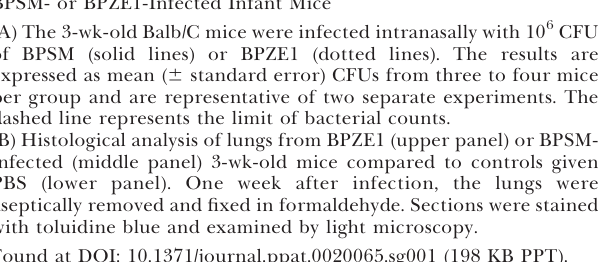
Figure S1. Lung Colonization and Histological Analysis of Lungs from BPSM- or BPZE1-Infected Infant Mice (A) The 3-wk-old Balb/C mice were infected intranasally with 10 6 CFU of BPSM (solid lines) or BPZE1 (dotted lines). The results are expressed as mean ( 6 standard error) CFUs from three to four mice per group and are representative of two separate experiments. The dashed line represents the limit of bacterial counts. (B) Histological analysis of lungs from BPZE1 (upper panel) or BPSM- infected (middle panel) 3-wk-old mice compared to controls given PBS (lower panel). One week after infection, the lungs were aseptically removed and fixed in formaldehyde. Sections were stained with toluidine blue and examined by light microscopy. Found at DOI: 10.1371/journal.ppat.0020065.sg001 (198 KB PPT). Figure S2. Immune Responses Induced in Adult Mice by BPZE1 or aPV Immunization Anti-FHA (A), anti-PTX (B), anti- B. pertussis IgG heavy and light chain (H þ L) titers (C), and anti-FHA IgG1/IgG2a ratios (D) before (open columns) or 1 wk after BPSM challenge (filled columns) in BPZE1 or aPV immunized 8-wk-old mice, compared to controls. Antibodies were measured in individual mice, and the results are expressed as mean values ( 6 standard error) for four to five mice per group. Found at DOI: 10.1371/journal.ppat.0020065.sg002 (46 KB PPT). Protocol S1. Supplementary Materials and Methods Found at DOI: 10.1371/journal.ppat.0020065.sd001 (30 KB